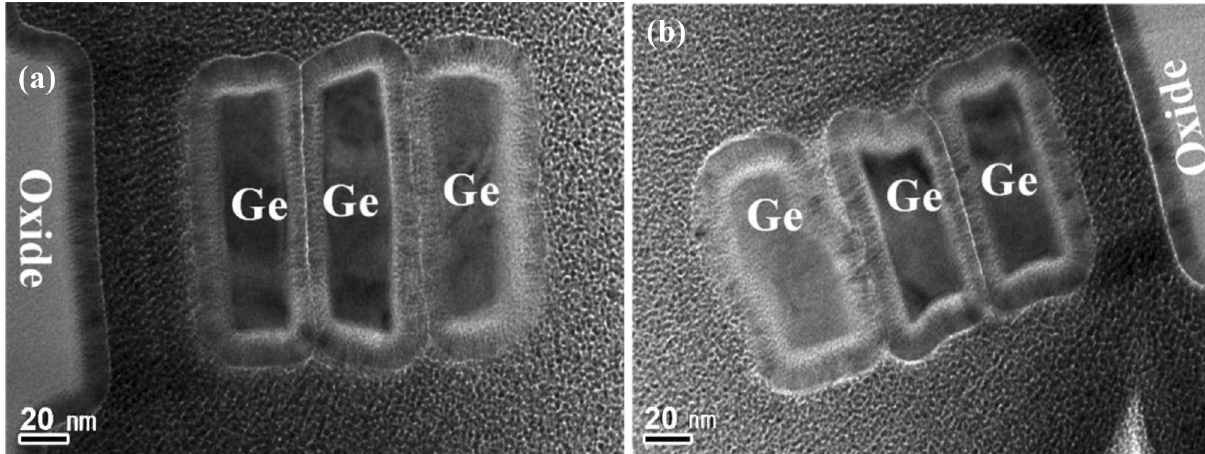
Figure 6. Cross-sectional TEM images of the stacked Ge nanosheets ( a ) before and ( b ) after annealing. The latter show that the dislocations can be easily removed by annealing (FGA, 600 °C/5 min) the suspended sheets.